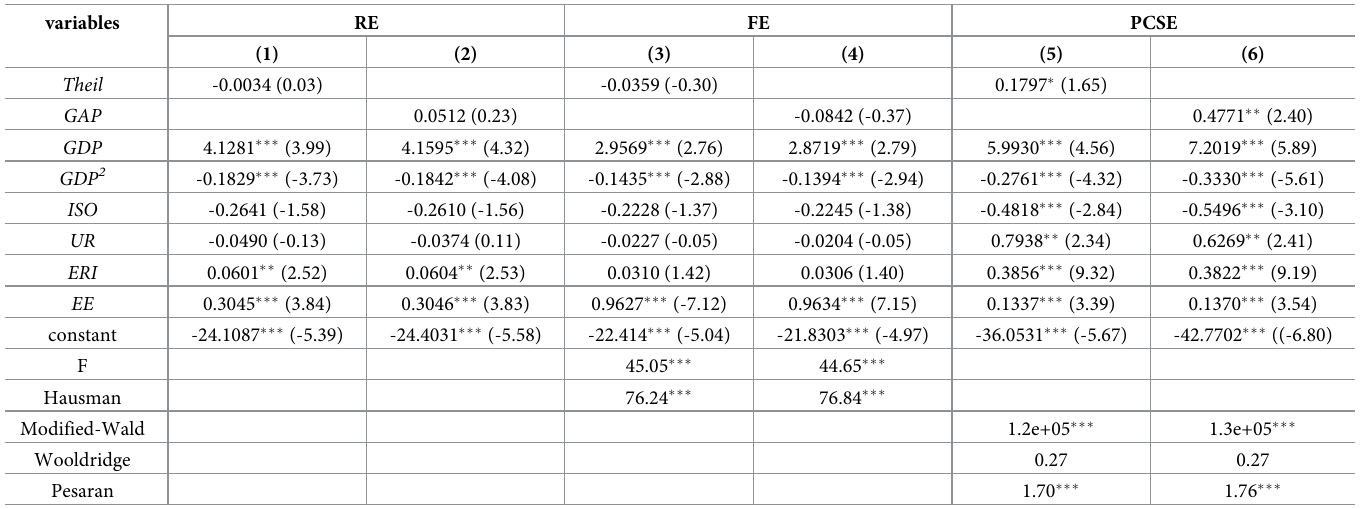
Table 3. Regressions of the urban-rural income gap on carbon emission reduction.